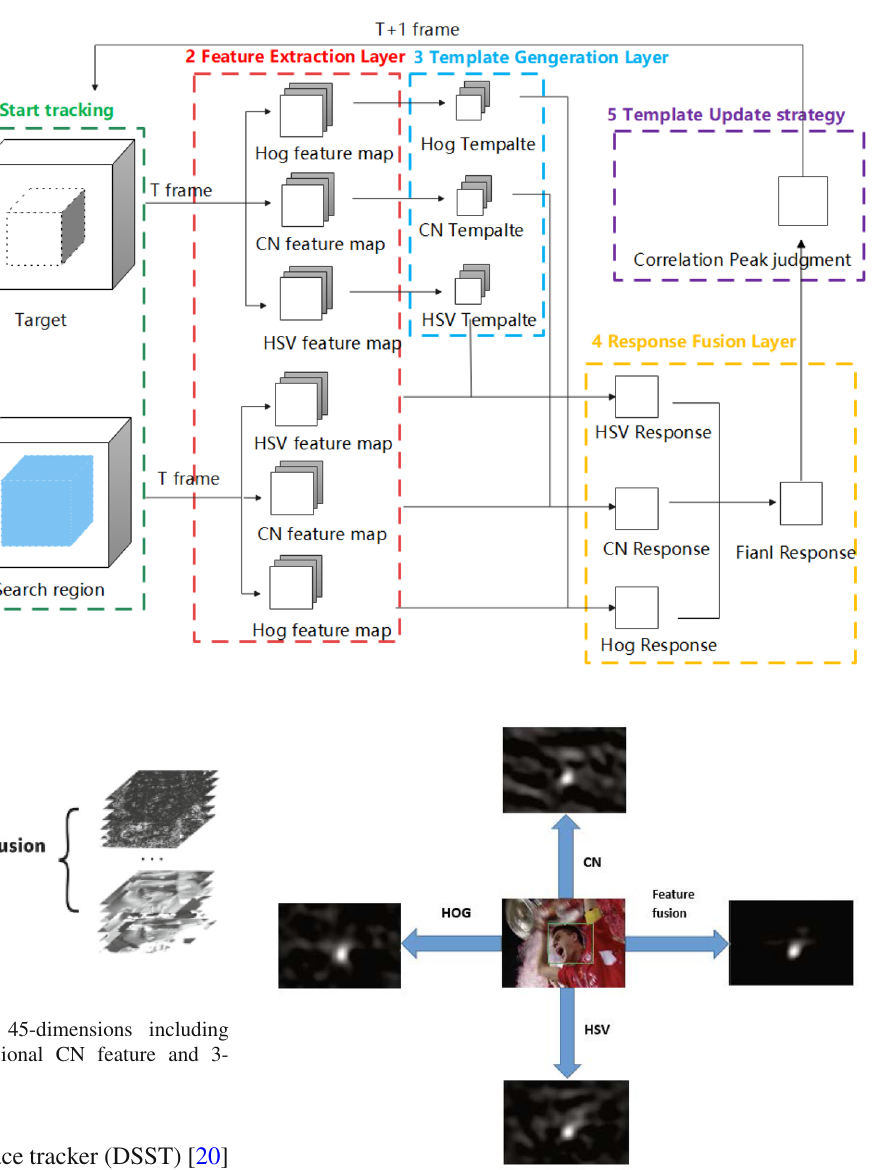
Fig.3 Fusion response graph. The single feature response graph being affected by a large amount of surrounding noise impacted accurate dis- tinguishingofthetarget,whilethefeatureresponseafterfusiondepicted a stronger discrimination between target and others